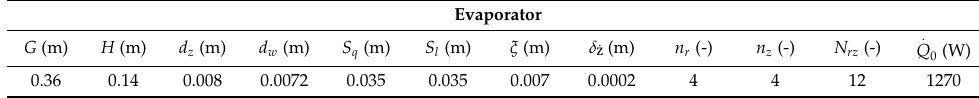
Figure 1. Geometry of the analysed exchanger. Table 1. Technical data of the analysed